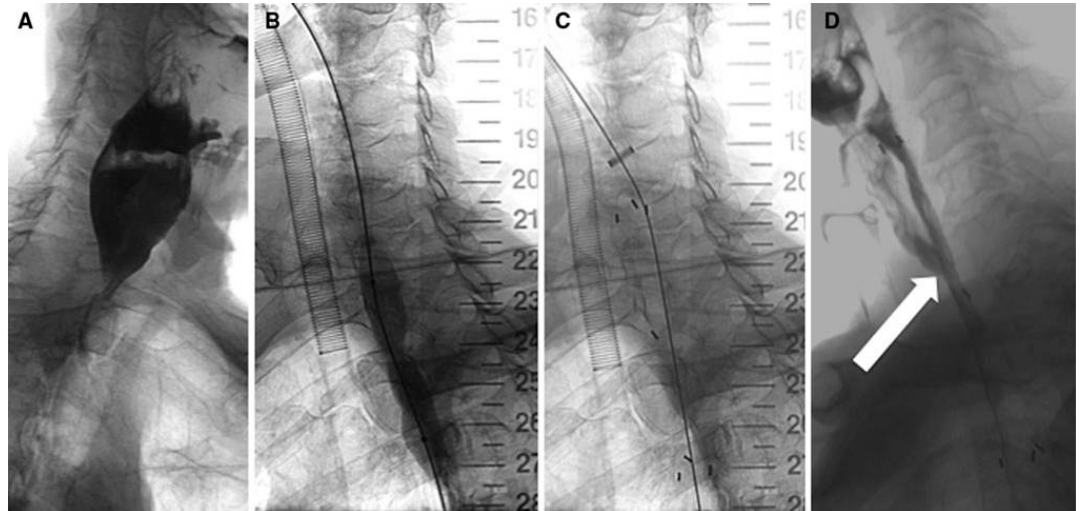
Figure 9. Patient with a high esophageal stricture due to recurrence of adenocarcinoma ( A ); contrast swallow showing the level of the stricture ( B ); a 14 mm × 60 mm balloon was used for predilation of the stricture ( C ); and a 25 mm × 60 mm biodegradable esophageal stent was inserted with the patient under general anaesthesia( D ). Contrast swallow three days later shows stent proximal migration and the presence of a tracheoesophageal fistula (arrow) [71]. Copyright permission from Springer. Acute